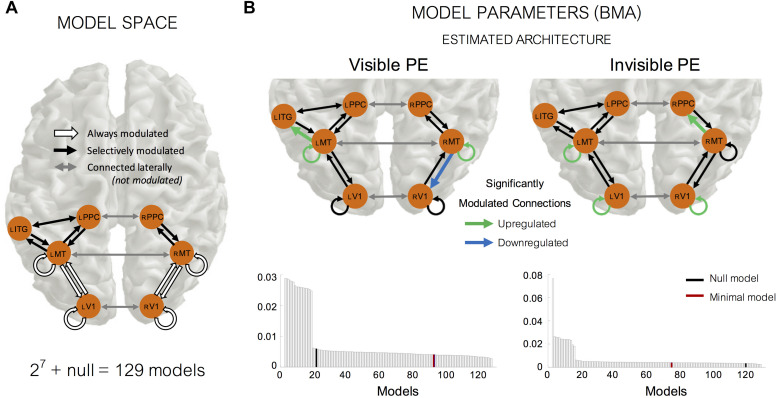
Dynamic causal modeling (DCM) for visible and invisible PE responses. (A) Model space showing the architecture used in all models and modulation of these connections. We used the same architecture in all models, what differed were the allowed modulations of the connection strength between nodes. We systematically varied the modulation direction of all black connections in a binary manner to obtain 27 = 128 models (+ a “null model” which did not have any modulation at or between any nodes). One of the 27 = 128 models also contained “the minimal model,” in which the only modulated connections were those between V1 and MT, and intrinsic modulation within V1 and MT. (B) Model evidence results from our random-effects (RFX) Bayesian Model Selection analyses, displayed as the exceedance probability of each model (i.e., the probability that a particular model is more likely than any other model given the group data). Using Bayesian Model Averaging (BMA) we were able to obtain weighted parameter estimates using the model evidence across all models and participants. Significantly modulated connections (false discovery rate corrected) are shown in green (upregulated) and blue (downregulated).